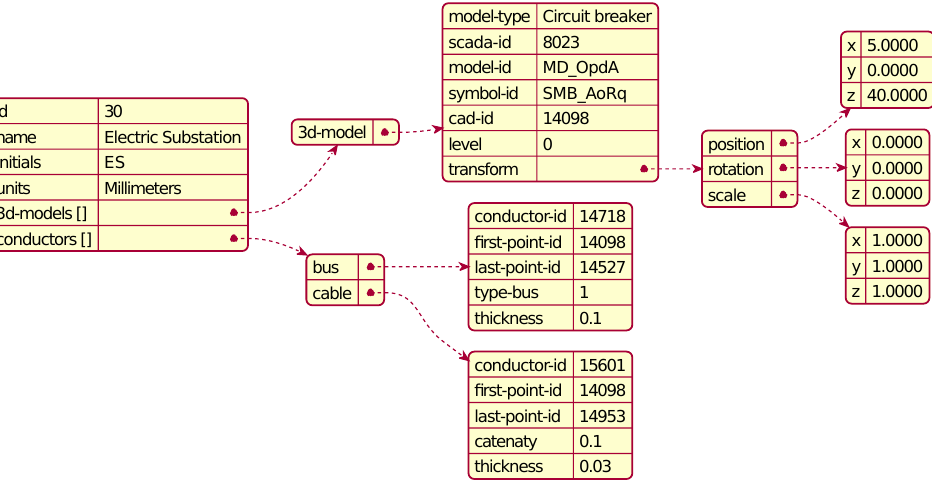
Figure 14. Data structure of the integration file between the CAD Editor and Virtual Reality software.